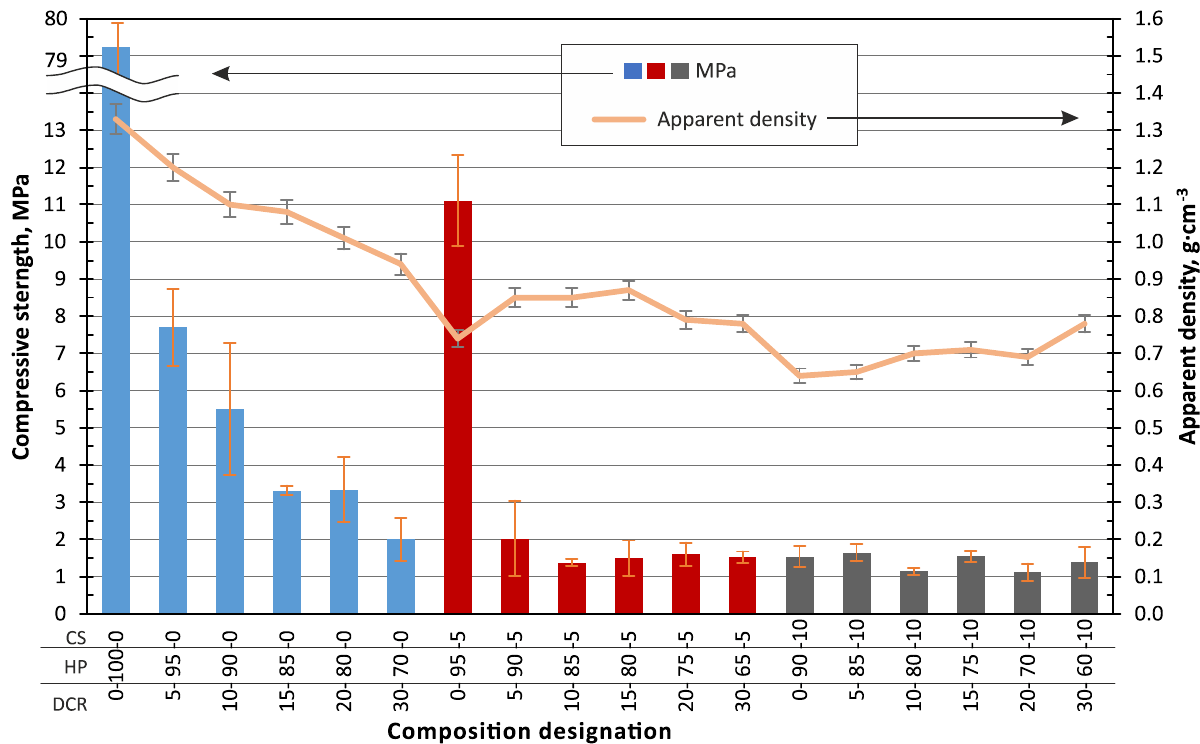
Figure 8. Dependence of the apparent density and compressive strength of the biocomposite in the shape of a block on the DCR and CS fraction. The composition of DCR HP and CS fraction is indicated by weight % in the wet